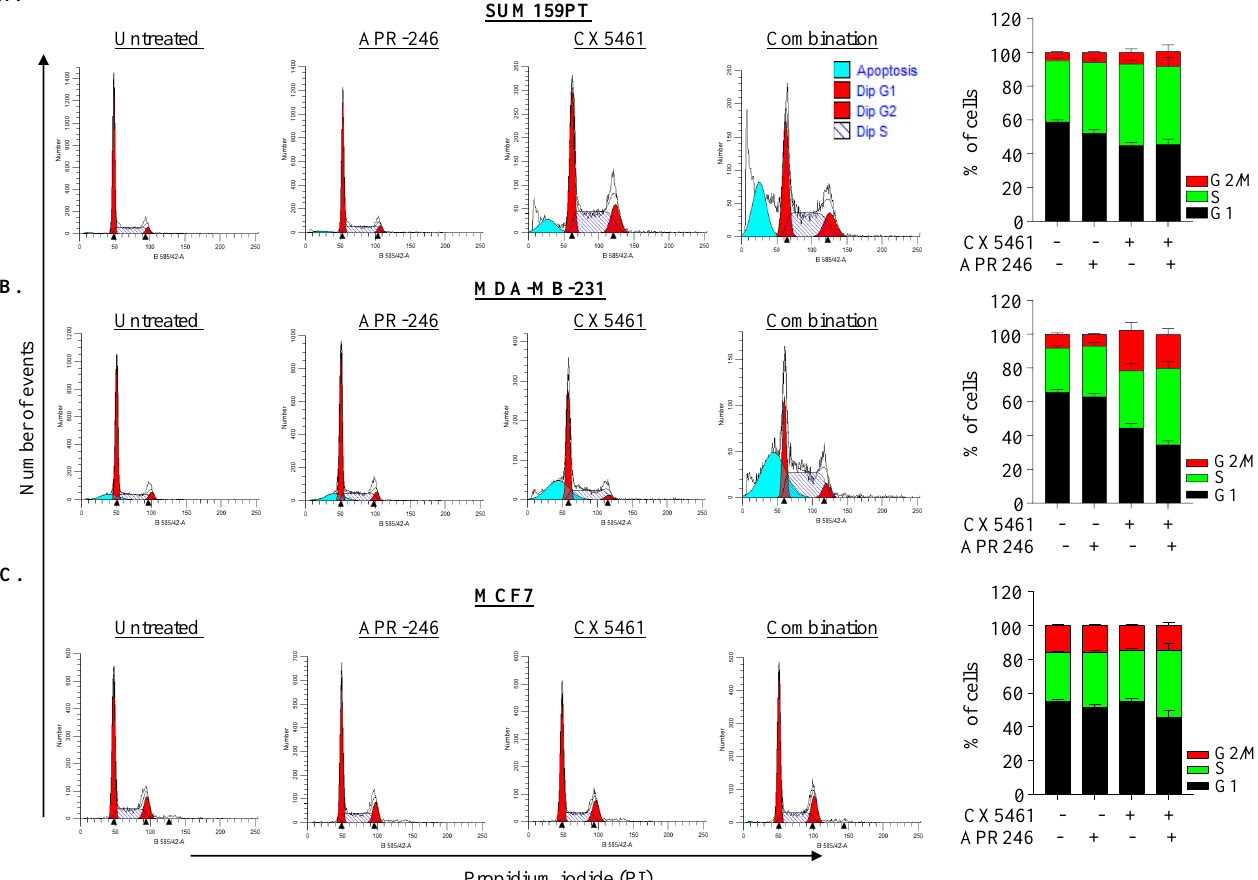
Figure 3. Impact of CX-5461 and APR-246 treatment on cell cycle perturbation. ( A – C ) Representative cytogram of SUM159PT ( A ), MDA-MB-231 ( B ) and MCF7 ( C ) cells showing cell cycle profiles following treatment with CX-5461 (0.5 µ M) and APR-246 (25 µ M) alone and in combination. Percentage of cell population in each phase of the cell cycle is shown. Graph represents the mean ± SD of two independent